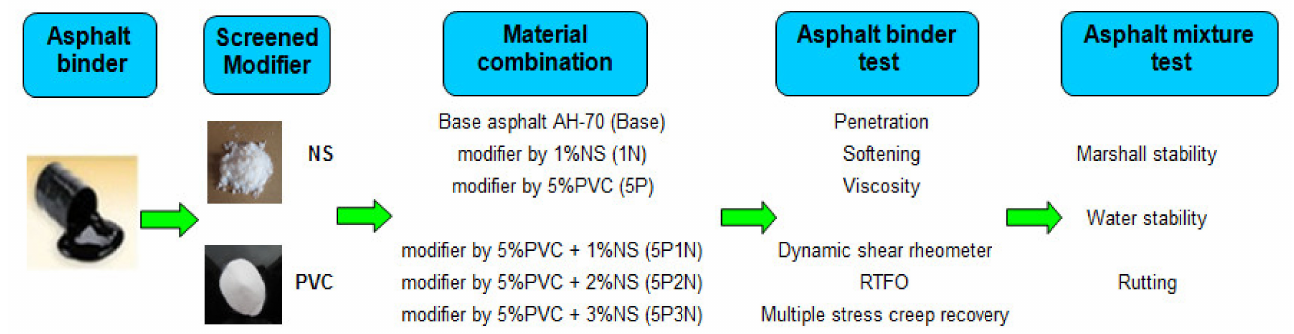
Figure 2. Experimental plan.